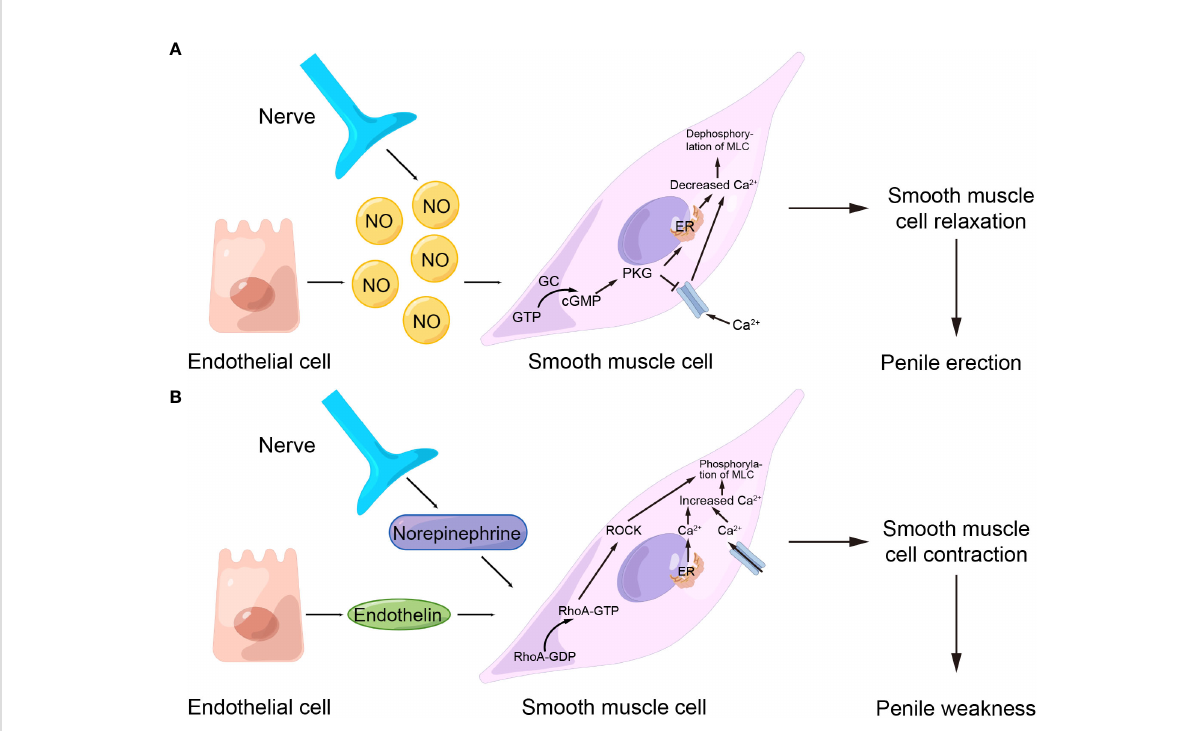
FIGURE 2 Important pathways that regulate penile contraction and relaxation. (A) NO/cGMP pathway. (B) RhoA/ROCK pathway. NO, nitric oxide; GTP, guanosine triphosphate; cGMP, cyclic guanylate phosphate; GC, guanylate cyclase; MLC, myosin light chain; ER, endoplasmic reticulum; ROCK, Rho-related protein kinase; GDP, guanosine